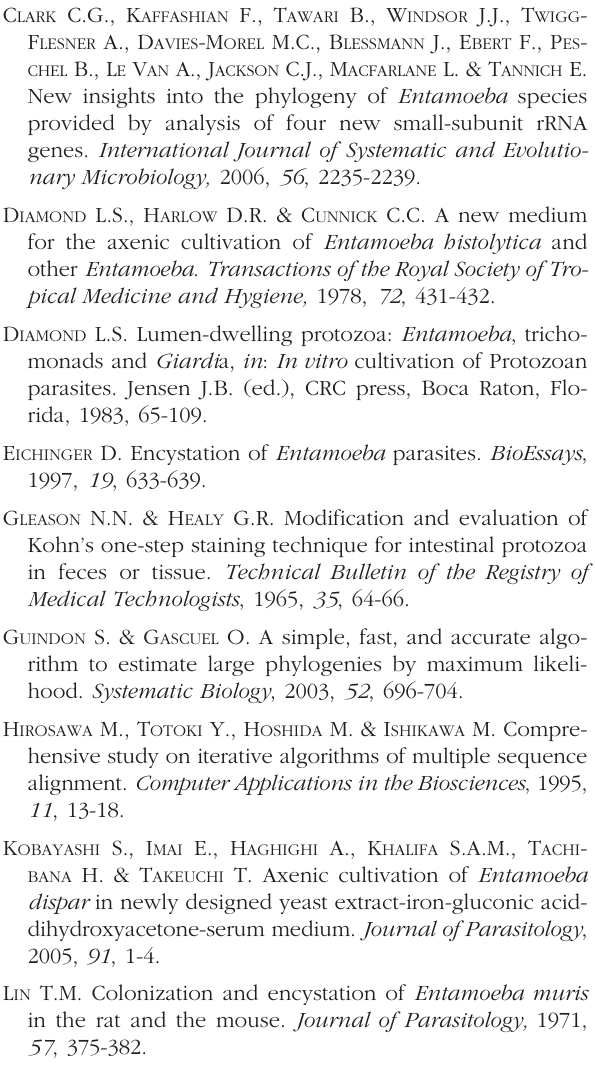
Fig. 4. – An unrooted phylogenetic reconstruction based on the SSU-rRNA gene sequences that explores the rela- tionships among Entamoeba species is shown. A maximum likelihood (ML) tree derived using a general time reversible (GTR) model employing estimates of the proportion of invariable sites and the gamma distribution parameter of 0.423 and 0.169, respectively. Signifi- cant bootstrap support (> 500) from 1,000 replicates is indicated on the left of the supported node. The scale bar represents the evolutionary distance for the number of changes per site. The numbers within parentheses represent the corresponding GenBank accession